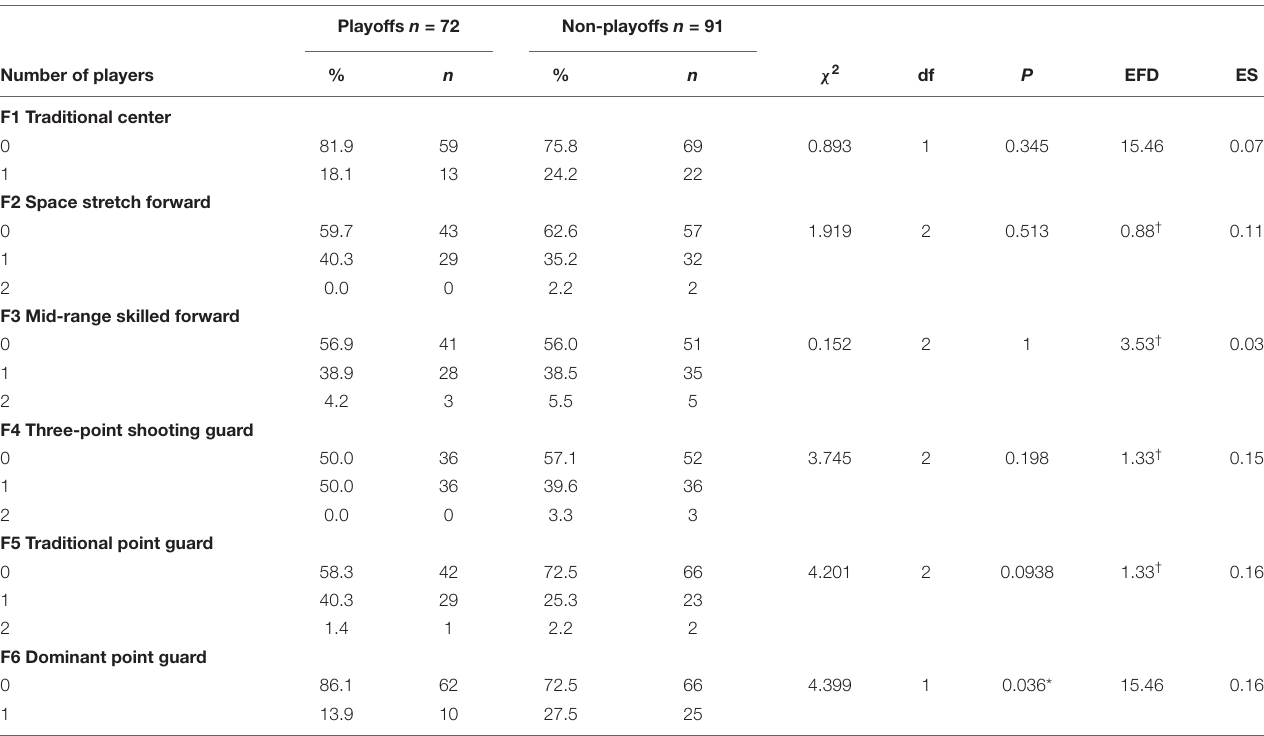
TABLE 3 | Frequency distribution (%) of team ability according to the number of foreign player clusters (crosstab command: Pearson’s Chi-square, degrees of freedom, significance, expected frequency distribution, and effect size). Playoffs n = 72 Non-playoffs n =